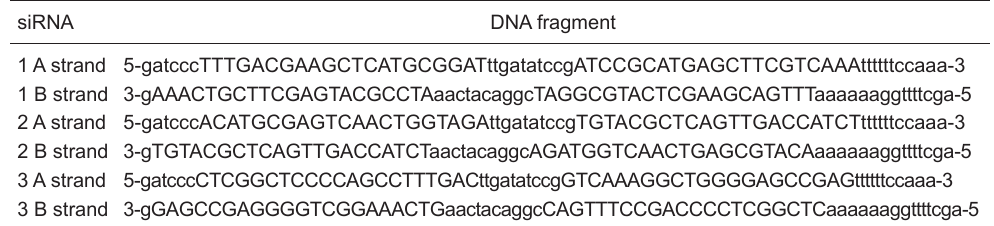
Table 3. DNA oligos of positive-sense strand and anti-sense strand for the siRNA expression vectors. siRNA DNA fragment